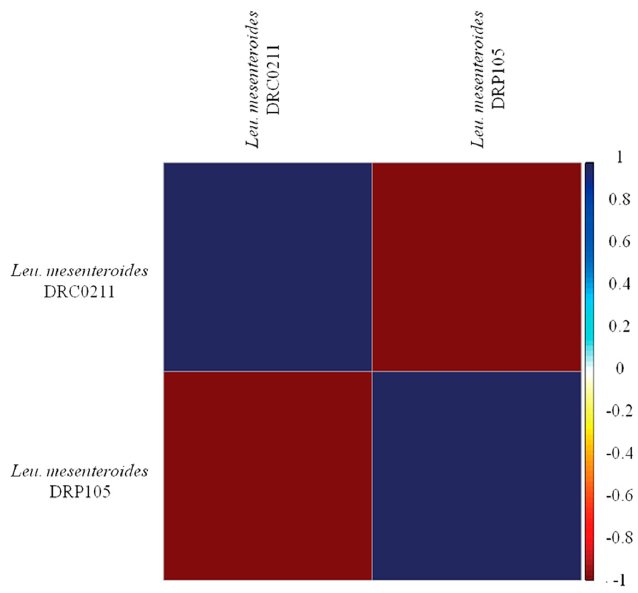
Figure 6. Average nucleotide identity (ANI) analysis of Leu. mesenteroides DRP105 and Leu. mesenteroides DRC0211.